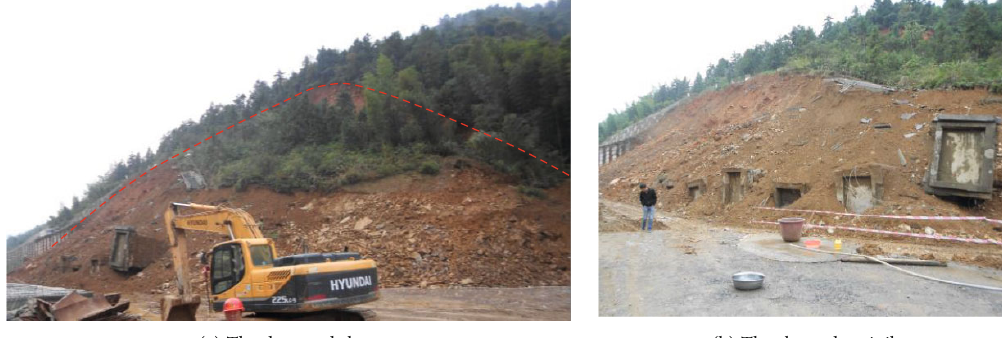
Figure 5: Photos of the landslide failure.